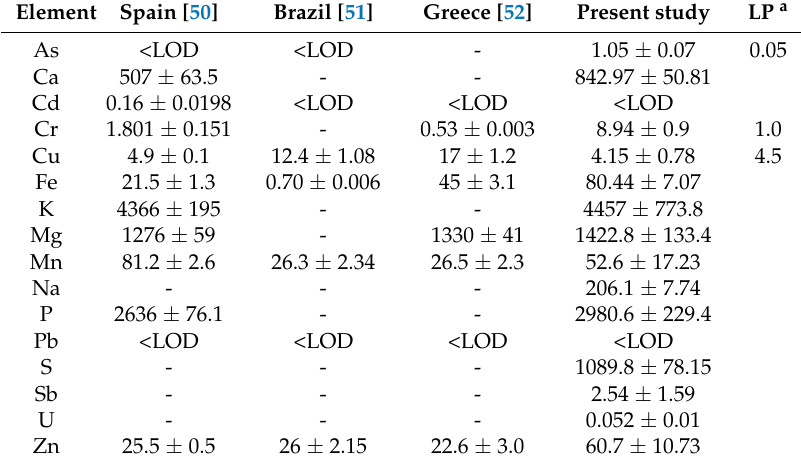
Table 5. Concentration of heavy metals and trace elements reported for walnuts in various parts of the world (literature values). Average concentration ( µ g/g) ± standard